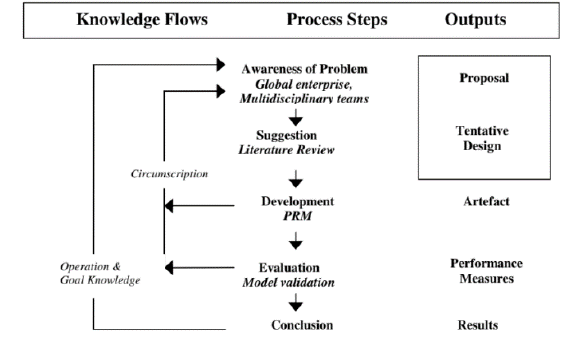
Figure 4. Adaptation of Design Research